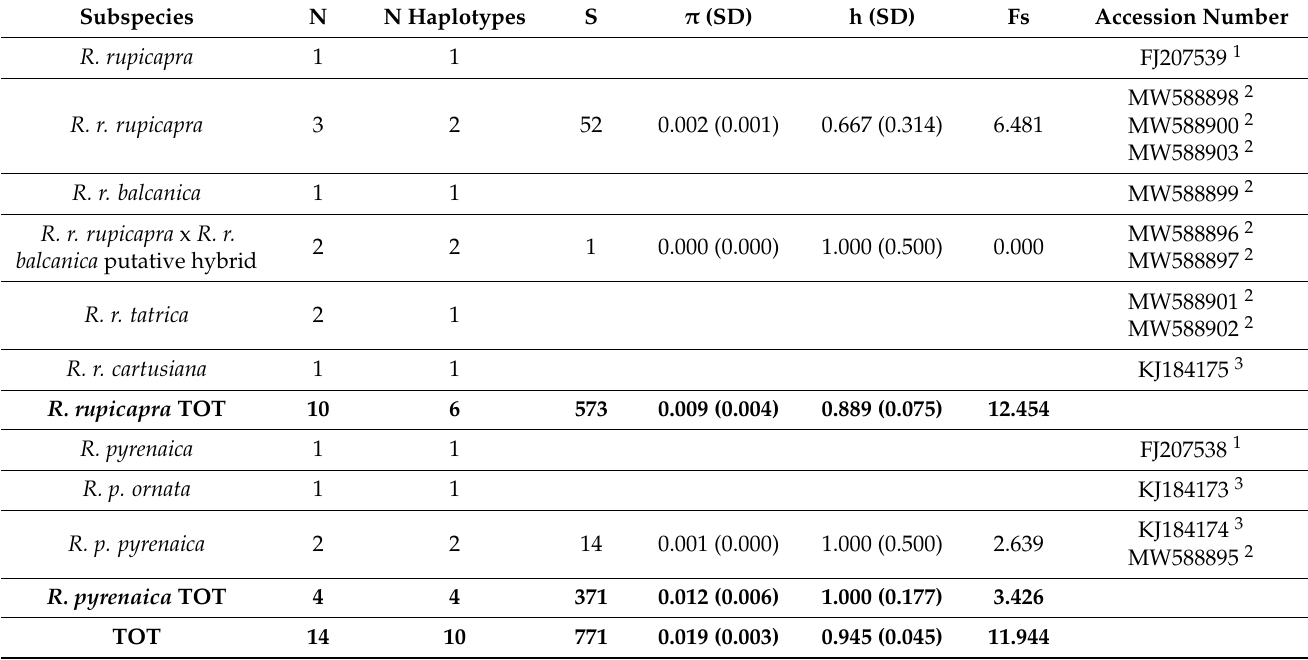
Table 1. Variability across the Rupicapra subspecies. N = number of individuals, N haplotypes = number of haplotypes, S = number of polymorphic sites, π = nucleotide diversity, h = haplotype diversity, SD = standard deviation, Fs = Fu’s Fs, TOT =